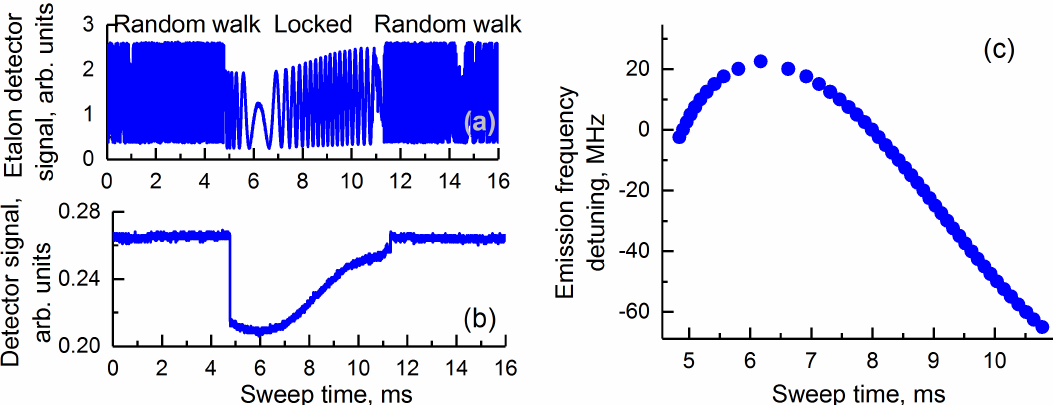
Figure 3. Measured dependence of the laser frequency ( a ), and power ( b ), on the change of the optical path from the laser to the resonator. The optical path change shown in units of time corresponding to the temperature rump of the phase section. The optical path is varied by scanning the temperature of the phase section between the laser and the resonator. The optical frequency is measured by sending laser light through an etalon while the power dependence is measured using a photodiode; ( c ) Variation of the self-injection locked laser emission frequency while optical path between the laser and the resonator is changing in time. The data are inferred from the measurement shown on panel ( a ). The laser frequency is undefined outside of the locking range since the change of the optical path does not impact the frequency of the free running (unlocked)